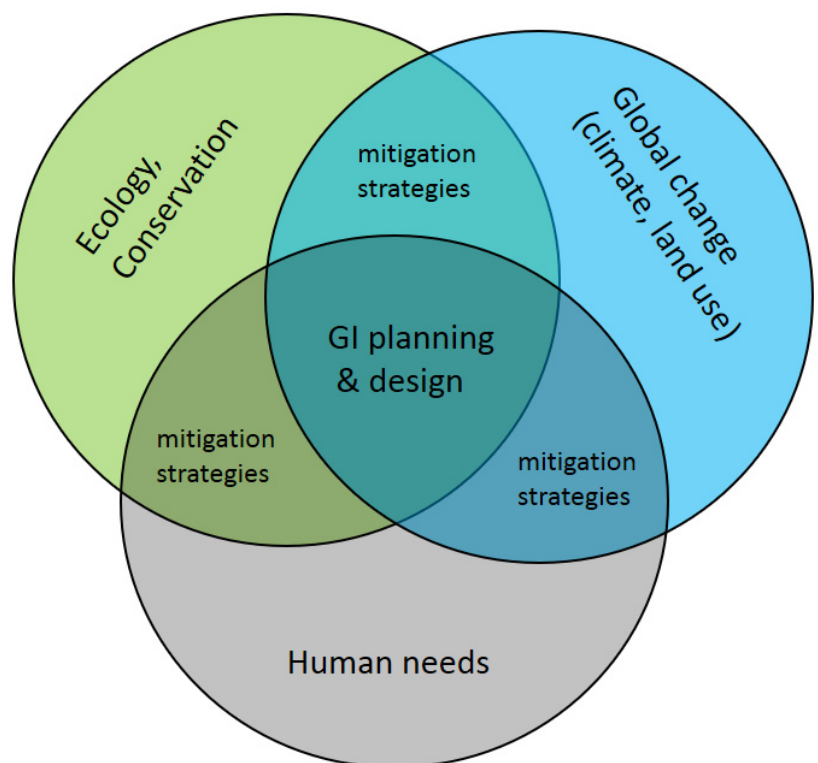
Figure 1. Global environmental change and human pressure require planning and design of green infrastructure (GI) to ensure long-term persistence of functional connectivity at the landscape scale in human-dominated areas.